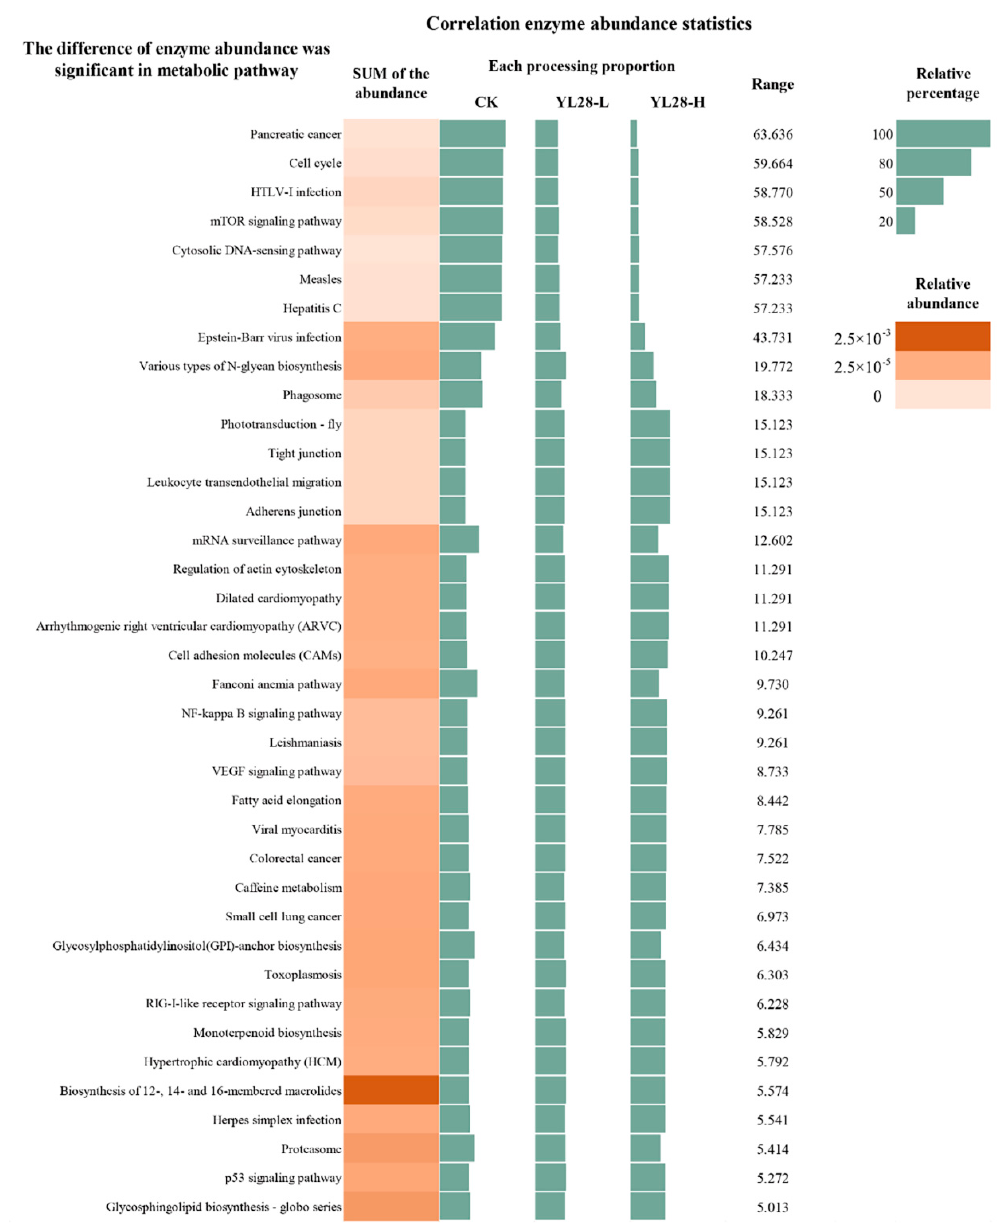
Figure 7. Variation of the average abundance of related enzymes in metabolic pathways (Range > 5%). Analysis of metabolic pathway screened the metabolic pathway-related enzyme abun-